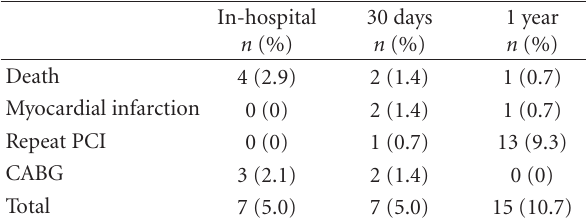
Table 2: Major adverse cardiac events.